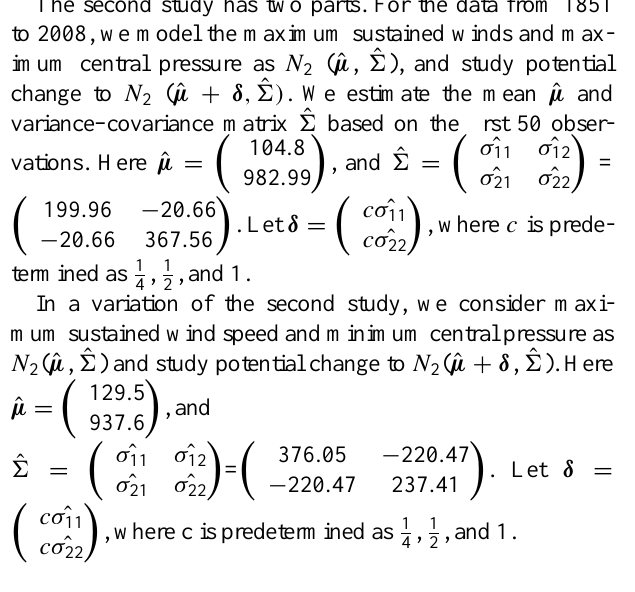
Figure 1. Performance comparison: EF CUSUM with Gaussian CUSUM. Dot-dash, dashed, and solid line stand for mean, median, and standard deviation. The top panel describes run length com- parison from Binomial(15,0.95) to Binomial(15,0.90), the middle panel describes run length comparison from Poisson(3) to Pois- son(3.1), the bottom panel describes run length comparison from Gamma(1,2) to Gamma(1.5,1.5). Due to length limitation of the graphs, we do not include the MAX line here.